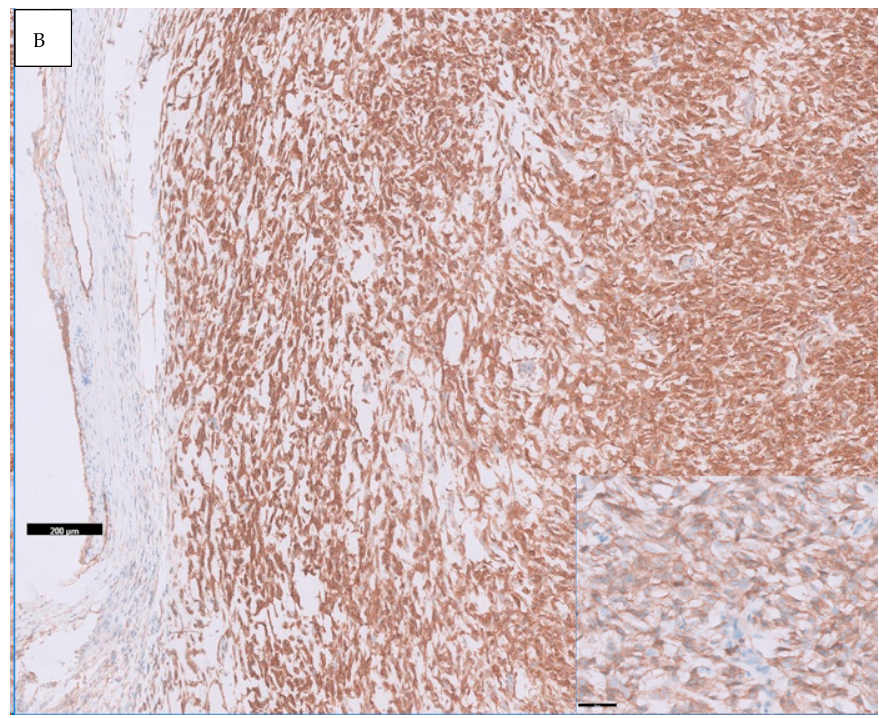
Figure 1. Spindle cell tumor on the deep soft tissue of the back with myxoid stroma (arrow) and diffuse cytoplasmatic positivity for pan-TRK IHC ( A : Hematoxyline-Eosine, scale bar 200 μ m, B : Antibody: EPR17341, Roche; Chromogene: DAB, scale bar 200 μ m, insertion 50 μ m).